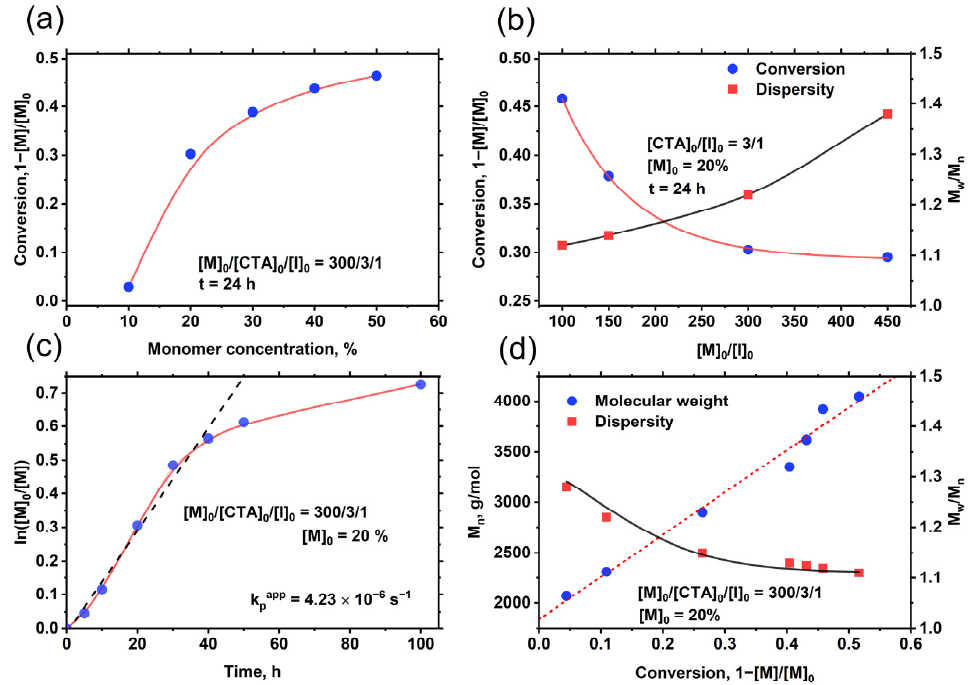
Figure 2. Dependence of monomer conversion during styrene RAFT polymerization using different monomer concentration ( a ) and initial molar ratio of monomer to initiator ([M] 0 /[I] 0 ) ( b ). Pseudo first order kinetic plot ( c ); evolution of molecular weight and dispersity as a function of monomer conversion ( d ). Polymerization conditions: T = 70 °C, [CTA] 0 /[I] 0 = 3/1, ([M] 0 represents the monomer concentration in polymerization mixture).